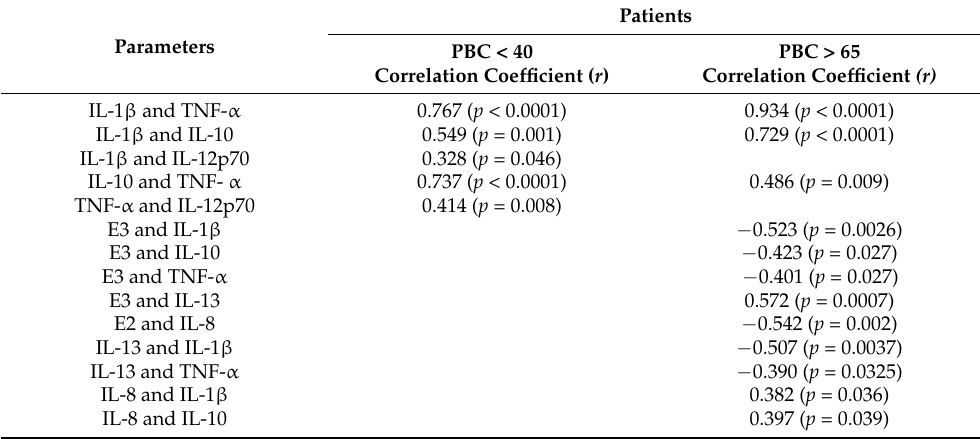
Table 1. Significant correlation between cytokines and estrogens in sera of PBC patients at an age of diagnosis under 40 ( n = 37) and above 65 ( n =